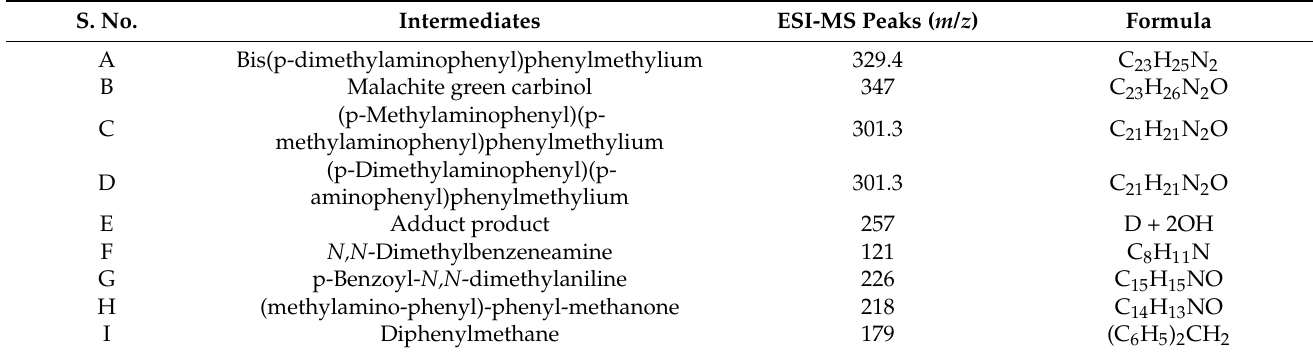
Table 3. Identification of the intermediates formed during the degradation of MG dye by